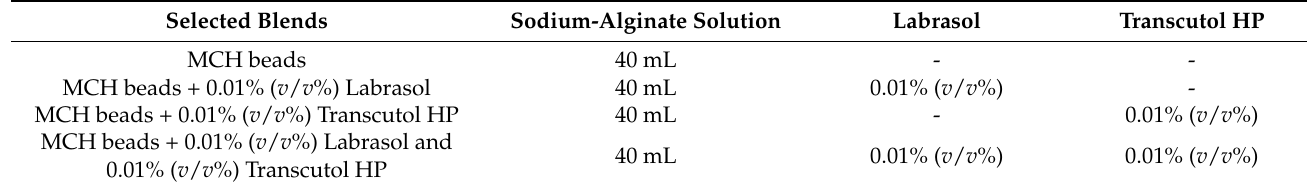
Table 1. Composition of the selected blends.